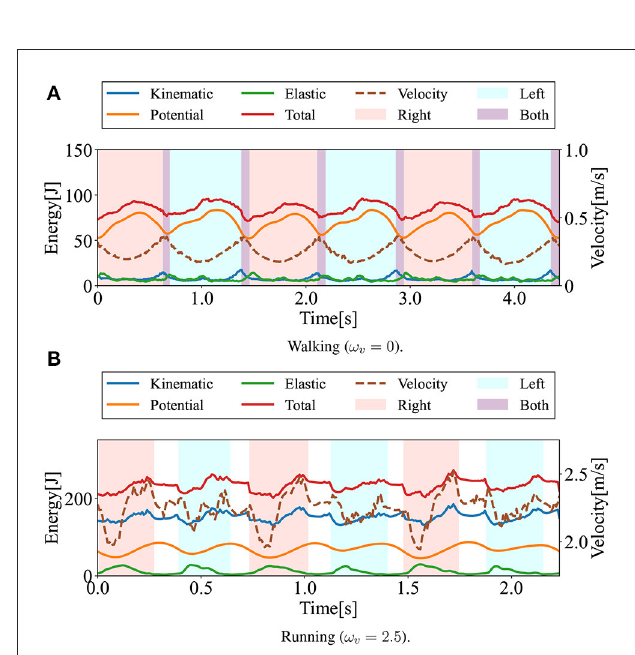
FIGURE4 Time evolution of energies during walking and running: kinetic (blue), potential (orange), elastic (green), and total (red) energies. The dotted lines represent locomotion velocity. The pink and sky blue colored areas represent the right and left single stance phase, respectively. The purple and white colored areas represent the double stance (DS) phase and the flight (F) phase. (A) Walking ( ω v 0) snapshot = 2.5) snapshot captured every = initial 500 thousand time steps, LP2 in the next 2.5 million time steps, and LP3 in the remaining 7 million time steps (Table 2).